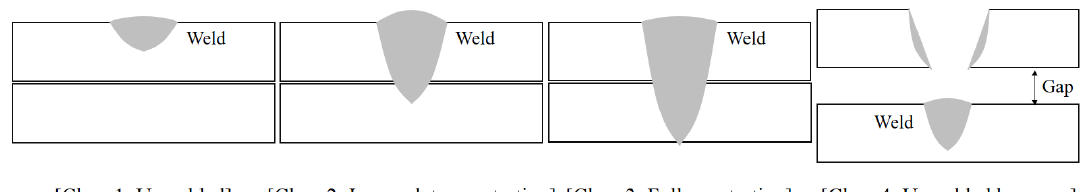
Figure 5. Schematics of four weld qualities defined in this study.